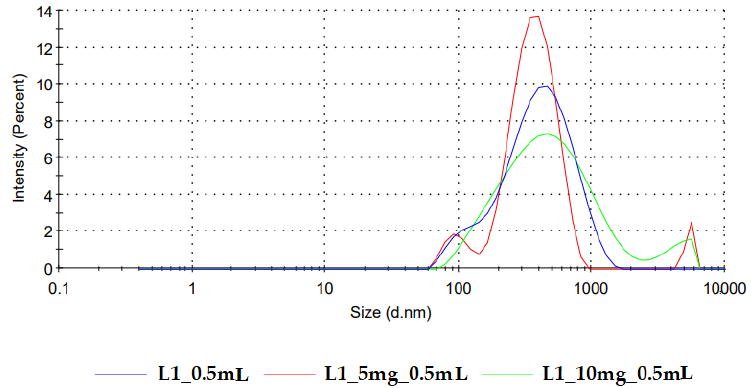
Figure 6. Particle size distribution of freeze-dried reconstituted samples of L1 milk and L1 milk loaded with increasing doses of loratadine.